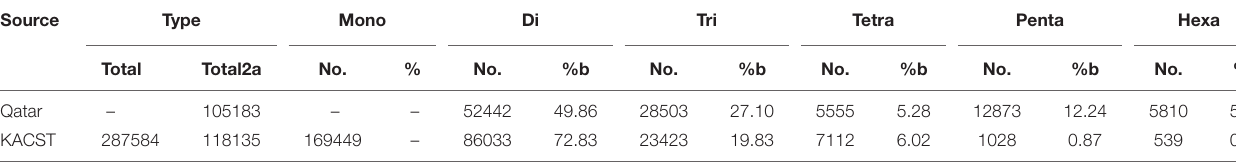
TABLE 1 | Frequency of various types of short sequence repeats (SSRs) in date palm.